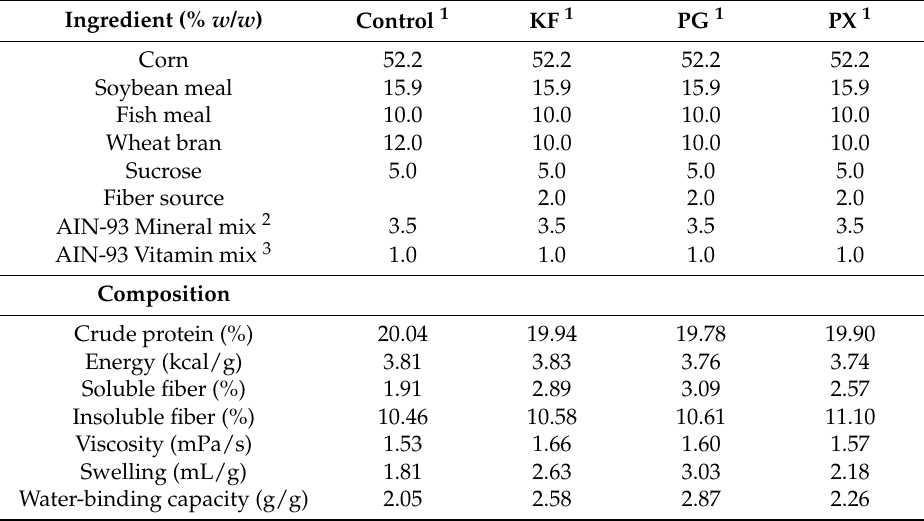
Table 1. Ingredient and composition of experimental